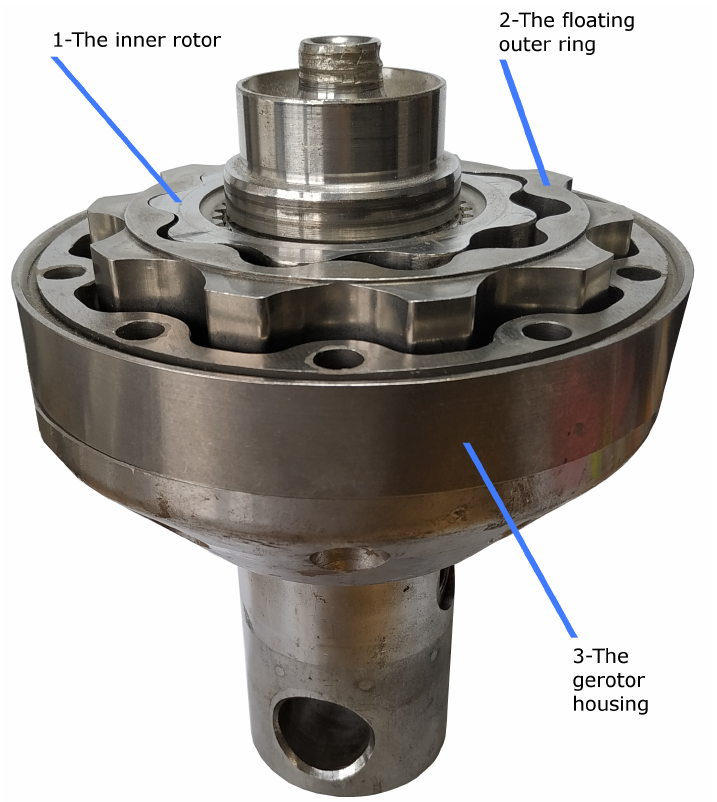
Figure 1. Half-assembled orbital hydraulic